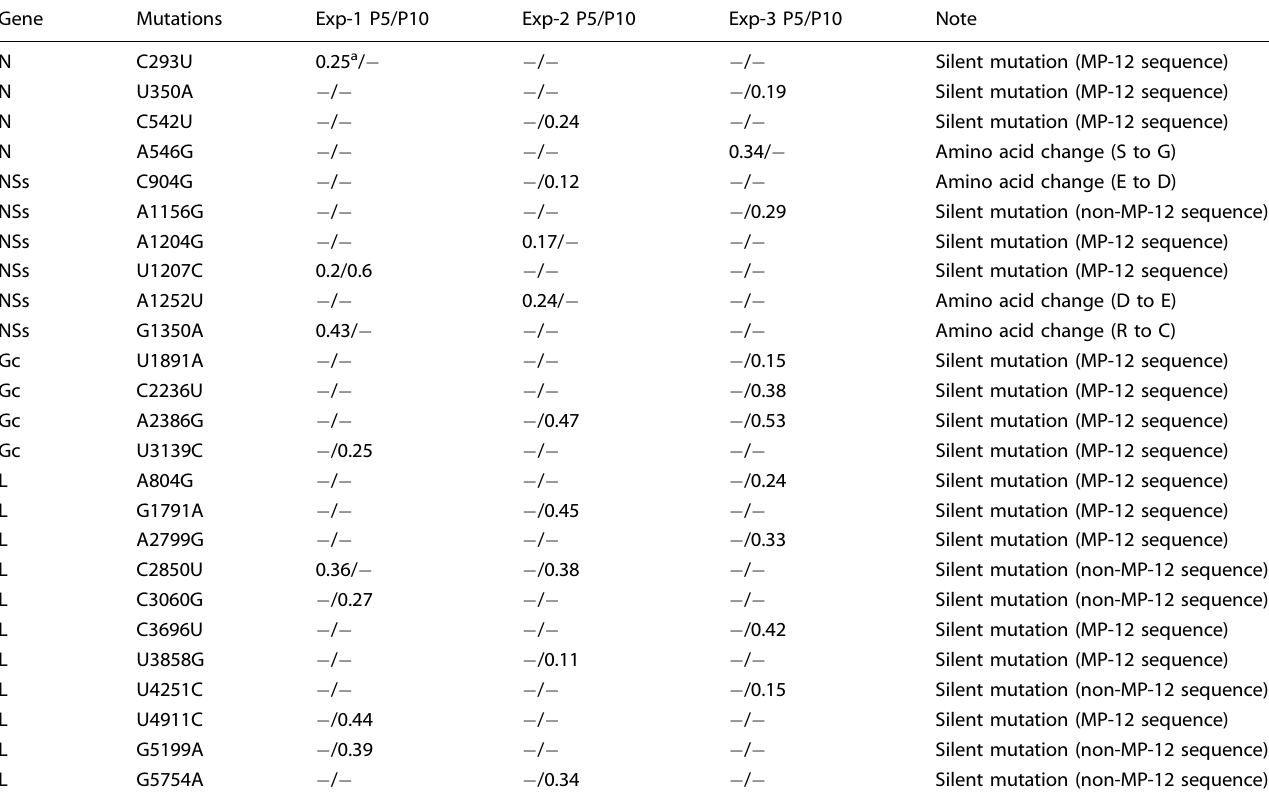
Table 1. Genetic subpopulation changes among 566 RVax-1 silent mutations during serial virus passages in Vero cells. Gene